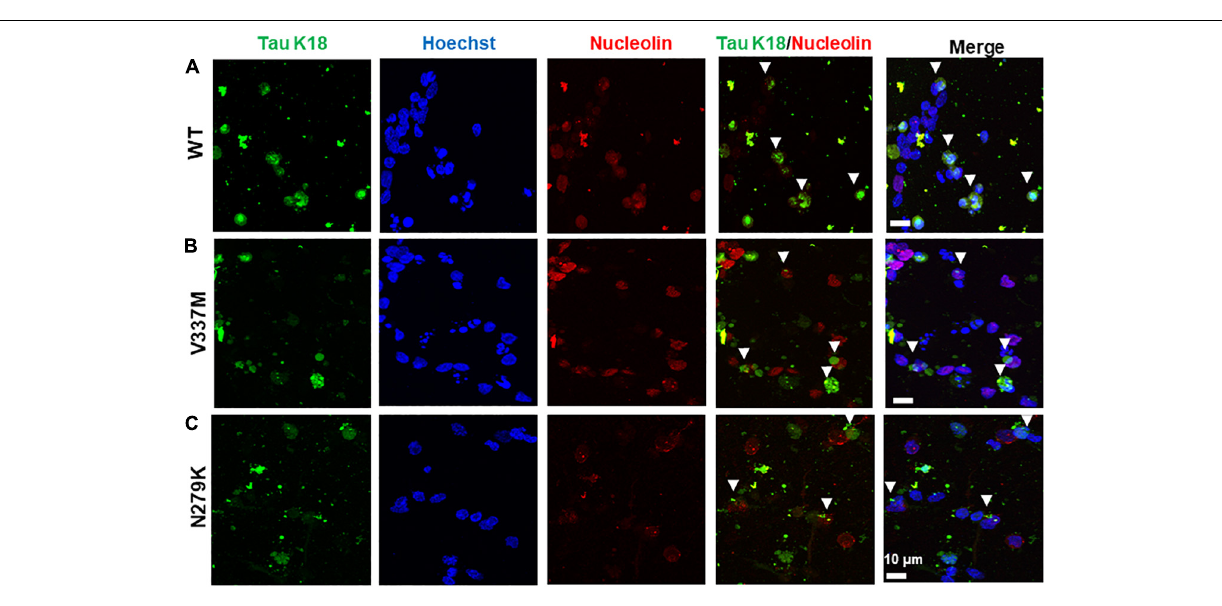
FIGURE 8 | Exogenous tau K18 oligomers internalized in the neurites of hiPSC-derived neurons co-localize with the nucleolar protein nucleolin. Panels (A–C) show the co-localization of internalized oligomers of WT, V337M, and N279K tau K18, respectively, with nucleolin. Scale bar = 10 µ m for all images. Figure extension in Supplementary Figures S8D–F